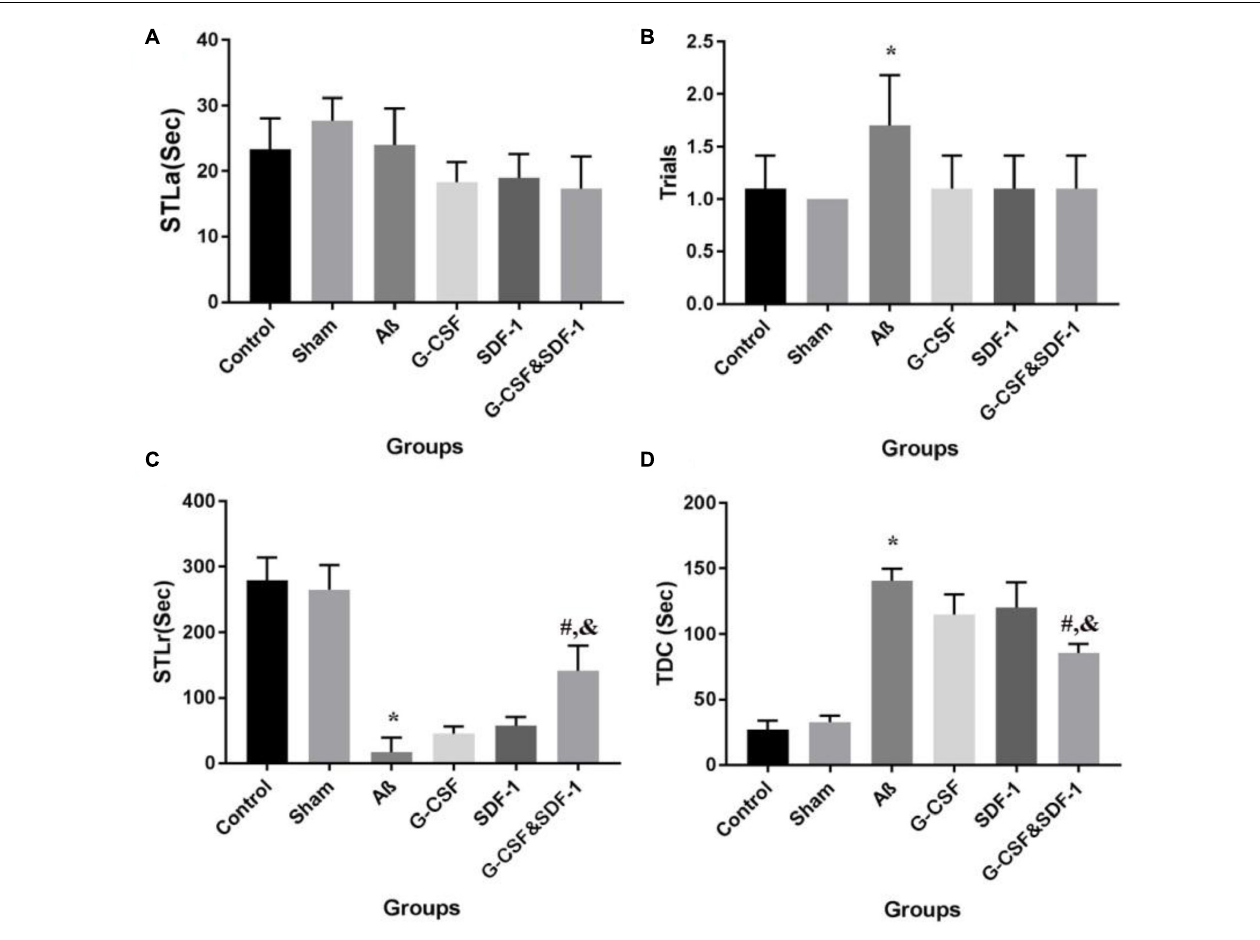
FIGURE 5 | Effect of SDF-1 and G-CSF treatment on passive avoidance learning task (A) , number of trials to acquisition in acquisition (B) , step-through latency in retention (C) , time spent in the dark compartment (D) . (* P < 0.05) as compared with control group. (# P < 0.05) as compared with G-SDF and SDF-1 groups. (& P < 0.05) as compared with A β group. Each column represents Mean ± SEM.